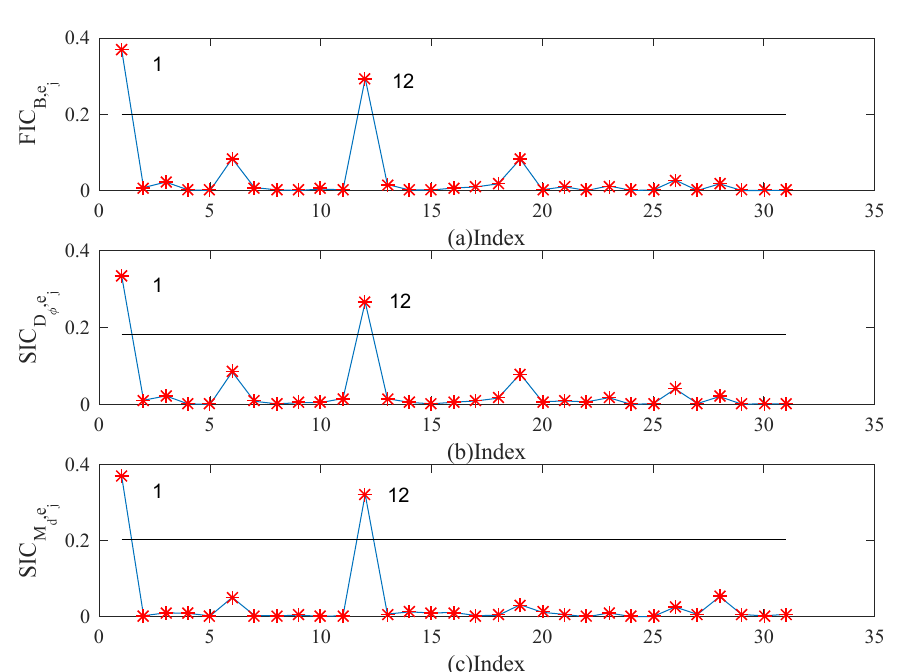
Figure 6. Plots of covariate perturbation in the real example.